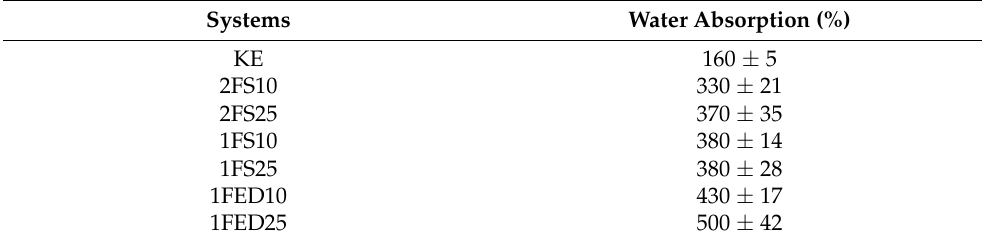
Figure 3. Water Imbibing Capacity of keratin (KE) and sample of functionalized keratin using a two ‐ (2) or one ‐ (1) stage process with either Succinic Acid (SA) or EDTAD (ED) of 10% (10) or 25% (25) as functionalizing agent. Table 3. Water absorption of the different systems obtained.